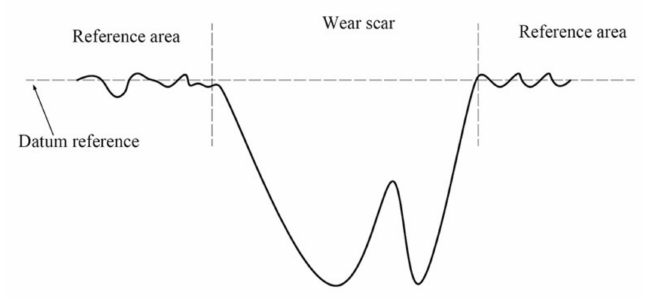
Figure 3. Schematic map for evaluating the wear